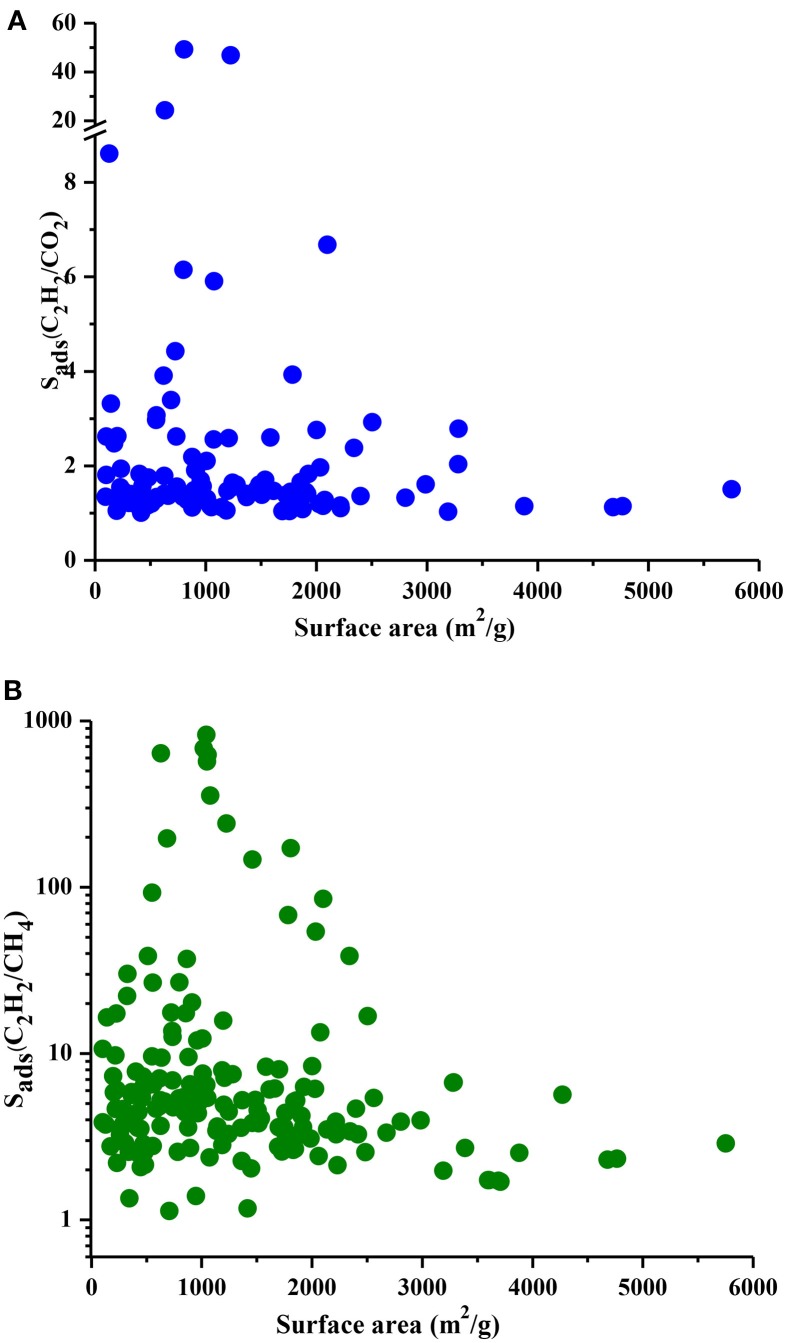
Sads and surface areas of MOFs for (A) C2H2/CO2 and (B) C2H2/CH4 mixtures.